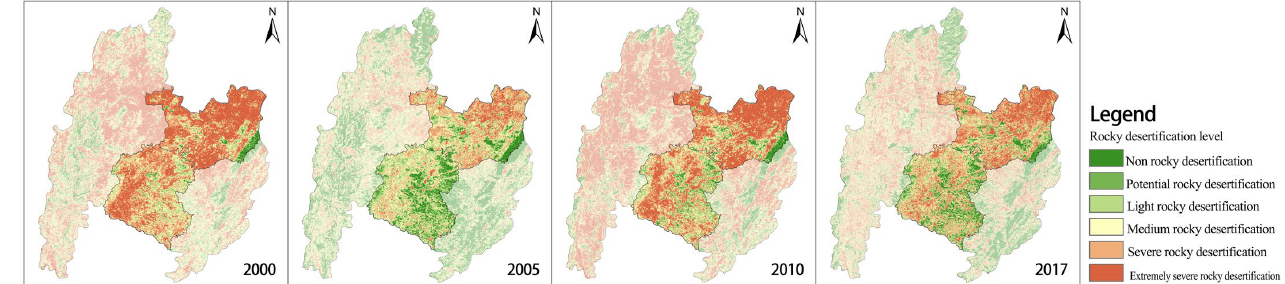
Figure 2. Dynamic evolution of rocky desertification level in the study area from 2000 to 2017.